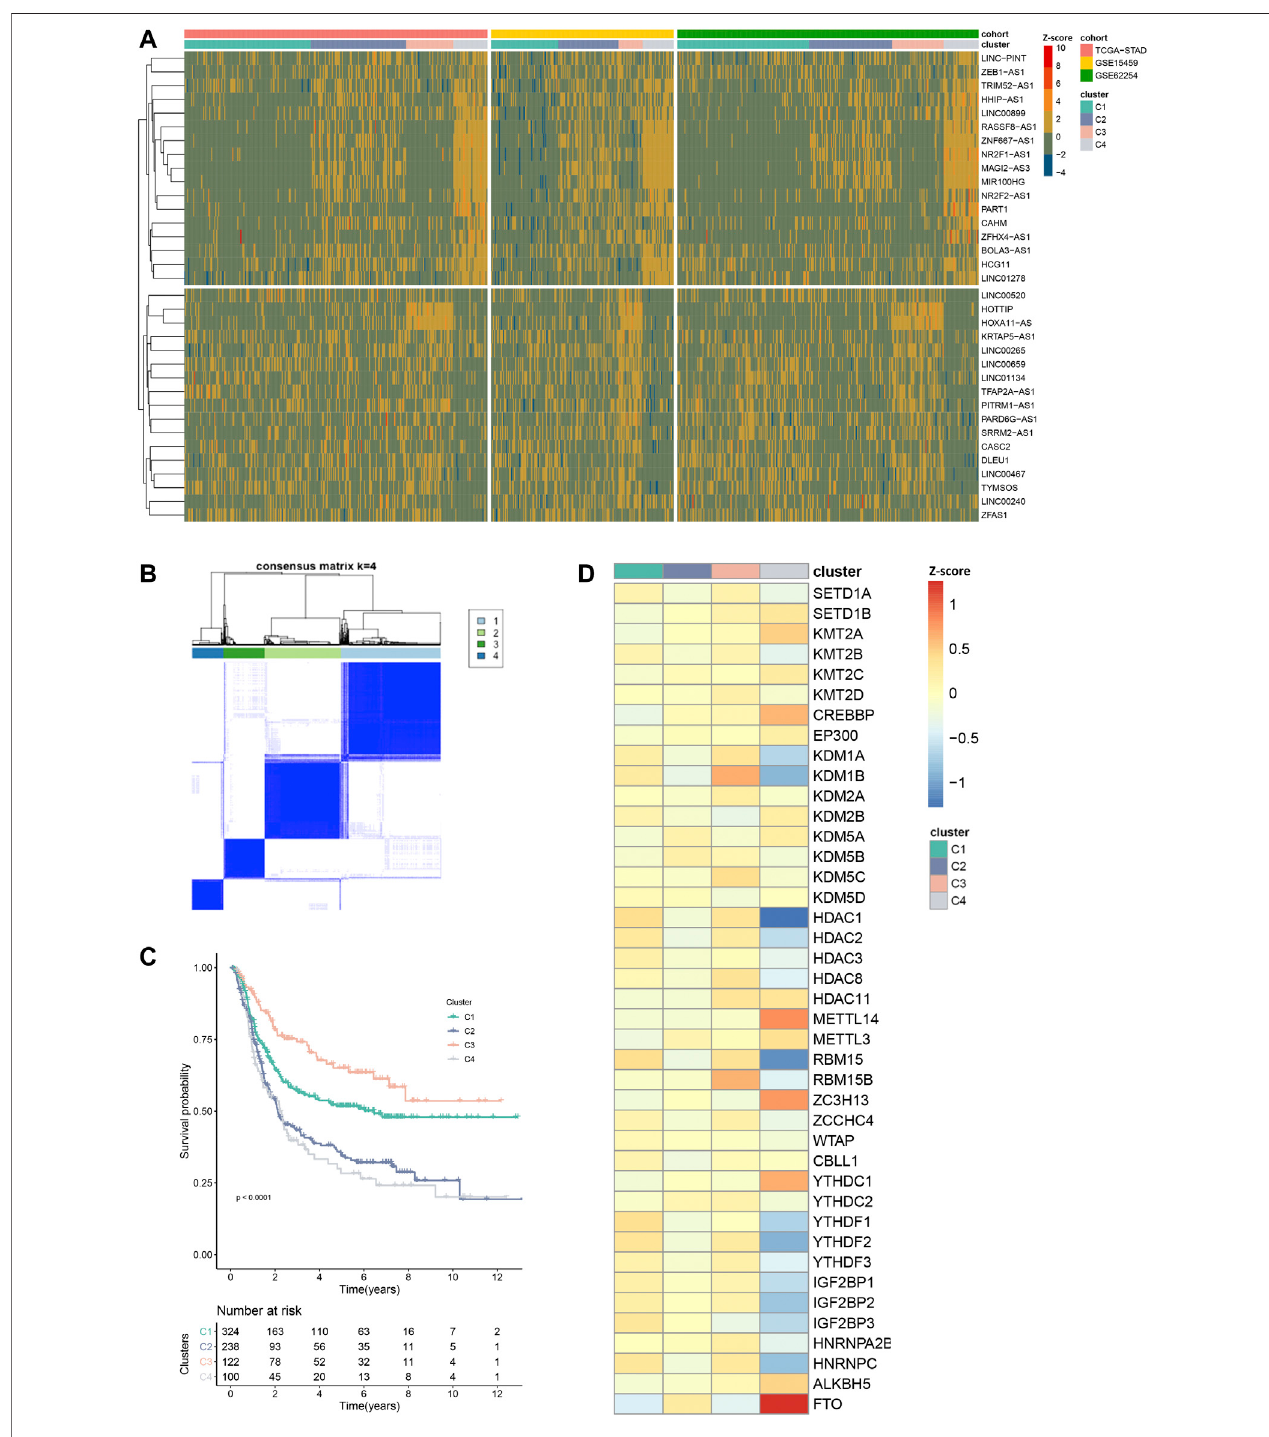
FIGURE 4 | Distinctive epigenetic modi fi cation patterns across three GC cohorts recognized by EMRL. (A) Heatmap showed the highly concordant expression patternsofthethreeGCcohortsintheexploringset. (B) Consensusunsupervisedclusteringdividedtheexploringsetintofourdistinctclusters. (C) Kaplan – Meiercurves showedthedifferentoverallsurvivalofthefourclusters. (D) Heatmapshowedthedistinctexpressionpatternsoftheepigeneticregulatorsintheexploringset.VIRMAand METTL16 were excluded in this section due to lack of expression information in the GSE15459 or GSE62254 cohort.